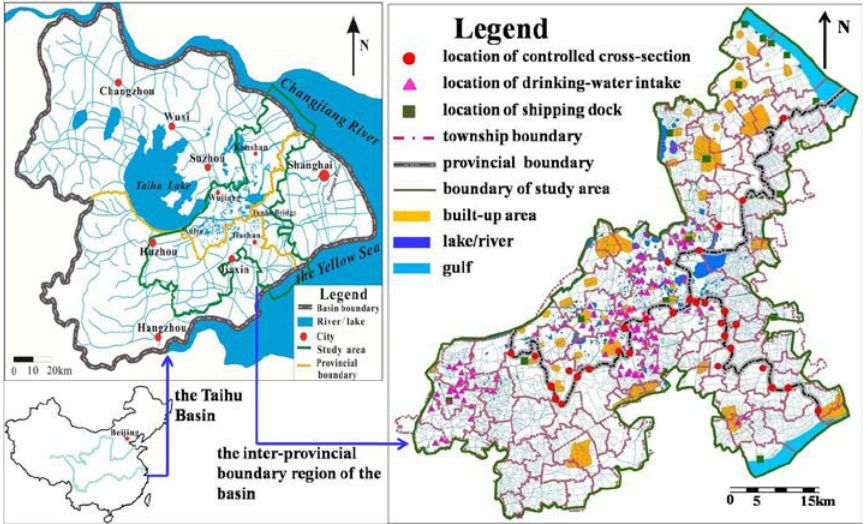
Figure 1. Sketch map of the study